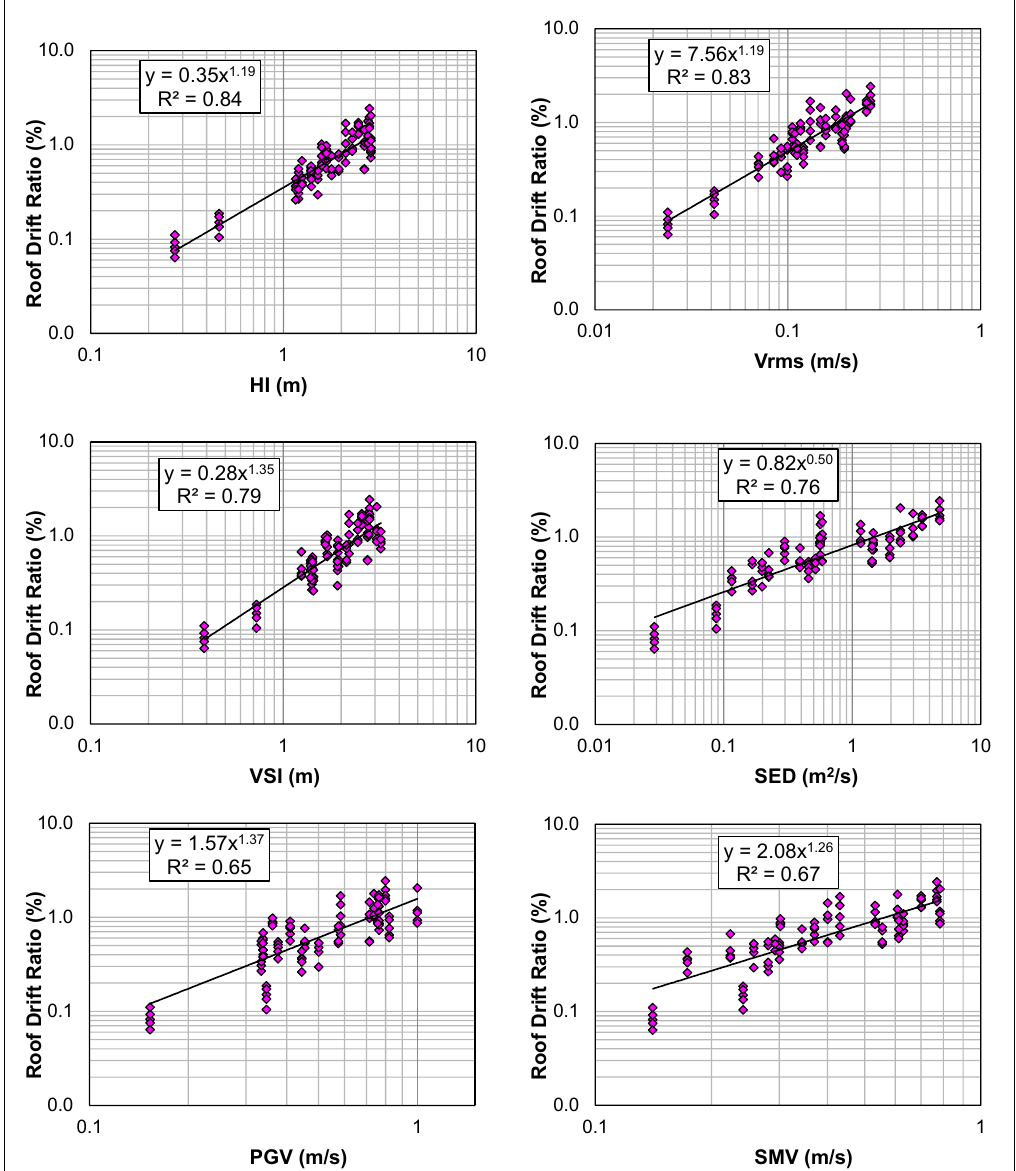
Figure 9. The correlation for roof drift ratio (RDR) of building models versus velocity related parameter values of the ground motion parameters. 0.00.10.20.30.40.50.60.70.80.91.0